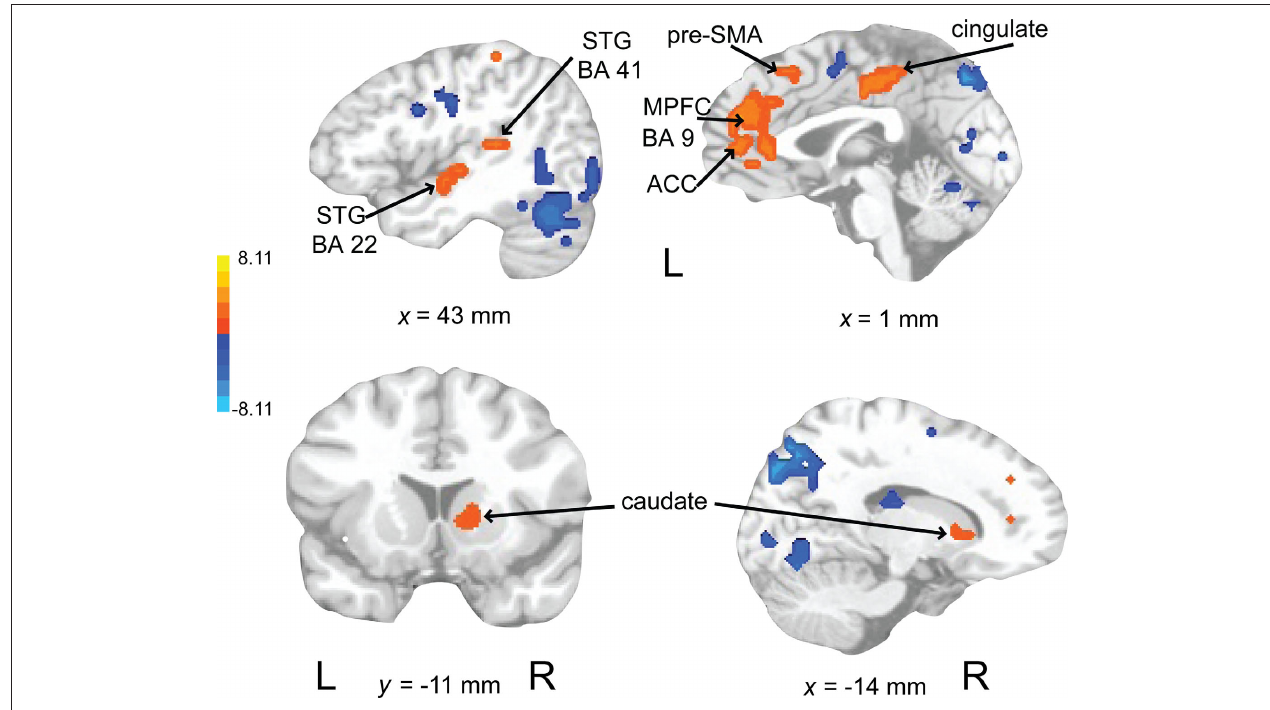
FIguRe 9 | Brain regions where BOLD signal was greater during the auditory attend 2 compared to visual attend 2 condition ( p < 0.002 corrected). Red to yellow colored voxels represent brain areas where auditory attend 2 > visual attend 2 . The coronal slice is shown with the left (L) on the left side of the figure. The colorbar reflects t -values. STG, superior temporal gyrus; pre-SMA, pre-supplementary motor area; MPFC, medial prefrontal cortex; ACC, anterior cingulate